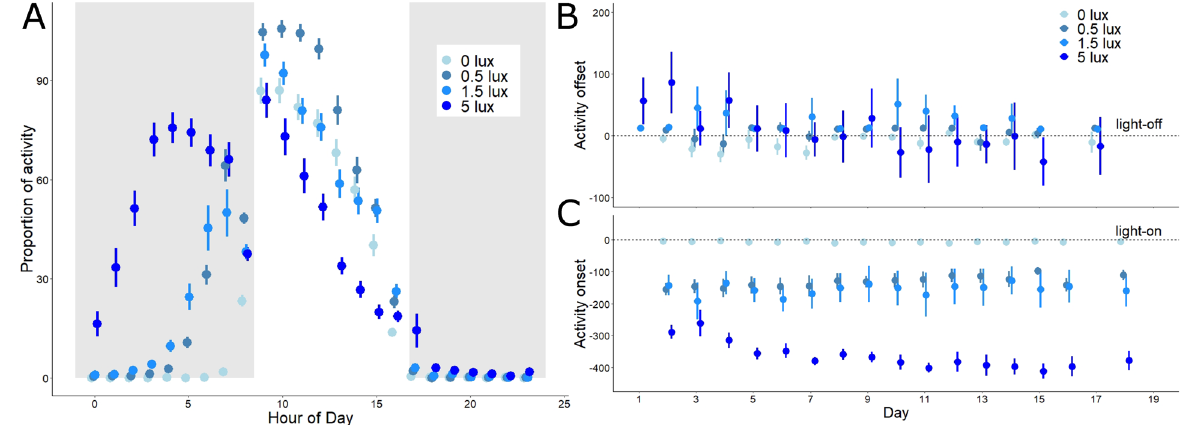
Figure 2. Activity timing is affected by intensity of ALAN. ( A ) Shows the proportion of active 2-min intervals in each treatment group per hour (raw mean ± SEM, N = 34). Grey background indicates night-time, white background indicates daytime. ( B ) and ( C ) show daily treatment group data (mean ± SEM), for the timing of evening offset and morning onset of activity, respectively (time in min). Activity onset and offset refer to times of lights-on and lights-off, which are shown as horizontal lines crossing